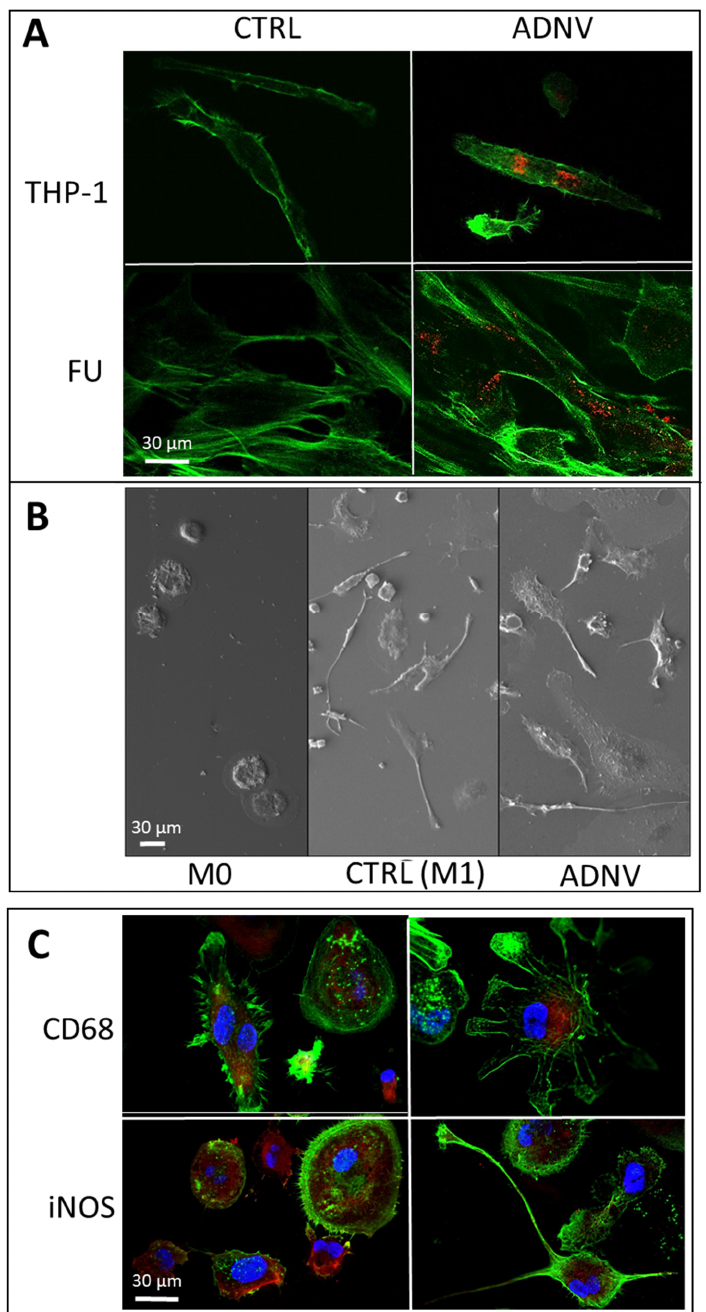
Figure 2. ( A ) ADNVs stained with fluorescent dye (in red) have been absorbed by THP-1 derived macrophages and fibroblasts (FU) stained in green. ( B ) SEM microscopy images show the morphology of non-active (M0), control, and ADNVs-treated macrophages. ( C ) THP-1 macrophages’ cytoskeleton is stained in green and nuclei in blue; red fluorescence indicates iNOS and CD68 immunostaining, respectively.